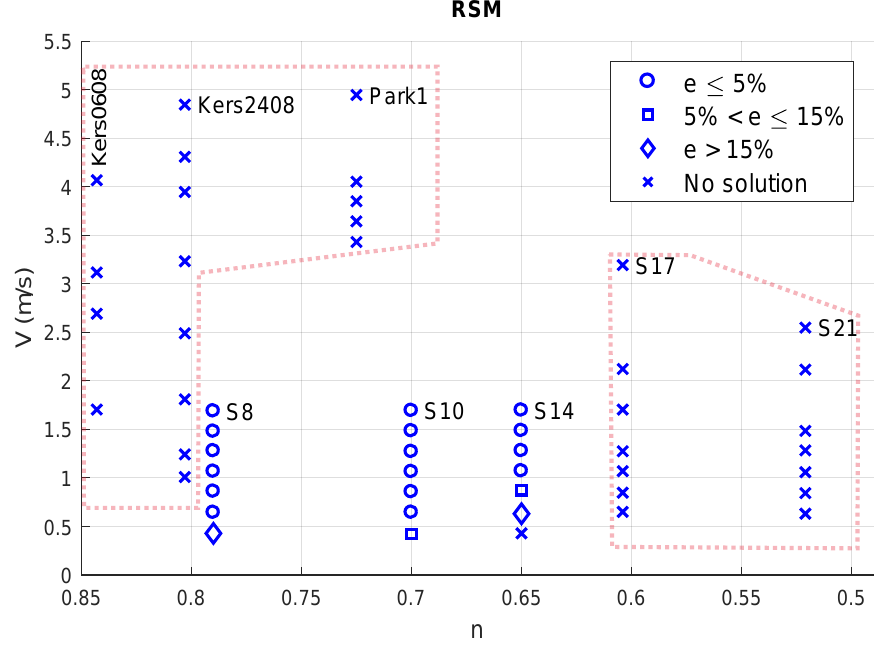
Figure 6. Error with the standard RSM without ψ 1 (or ψ 2 ).